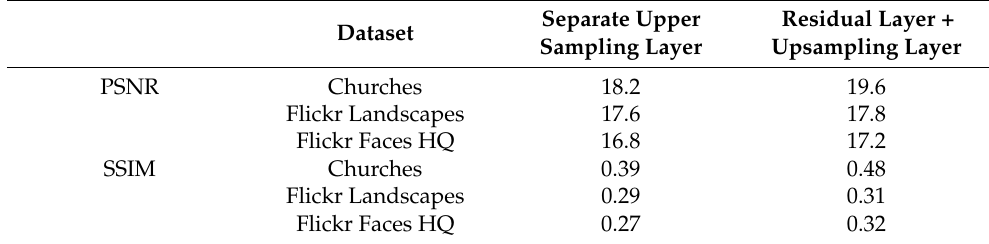
Table 3. Comparison of different modulation